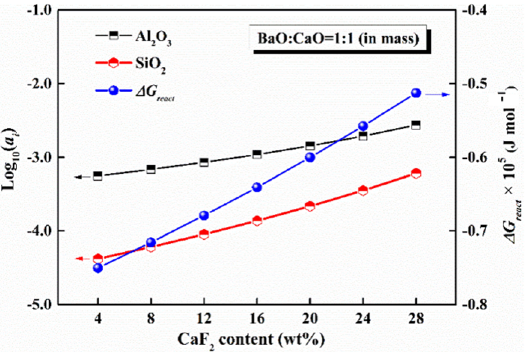
Figure 6. Effect of CaF 2 content on the activities of Al 2 O 3 and SiO 2 and the reactivity of mold flux.